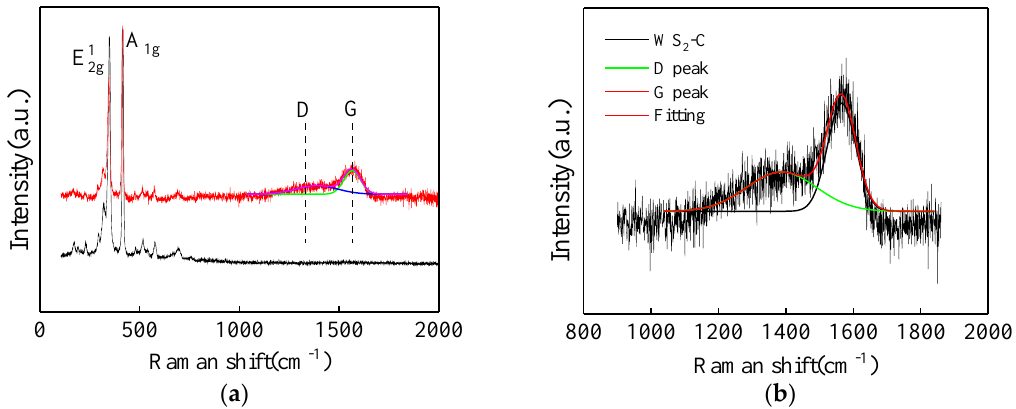
Figure 5. Raman spectra of WS 2 -C: ( a ) full spectra; ( b ) fitting spectra of D and G peaks.